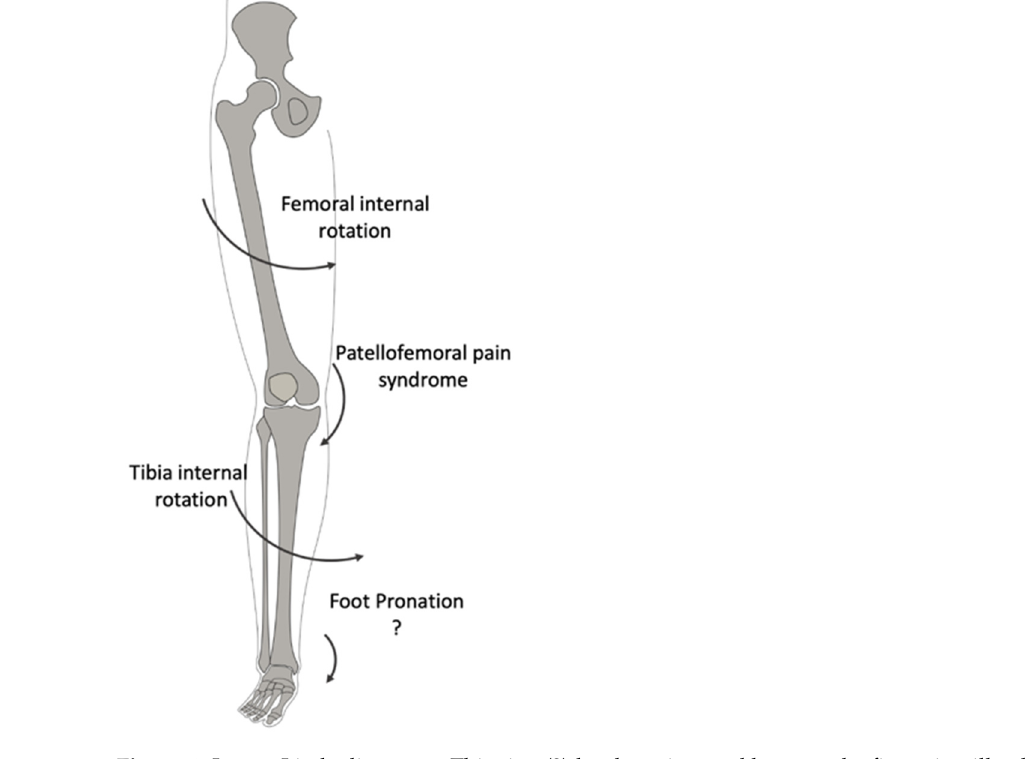
Figure 4. Lower Limb alignment. This sign (?) has been inserted because the figure is still a theorical explanation of the association between the two phenomenons.